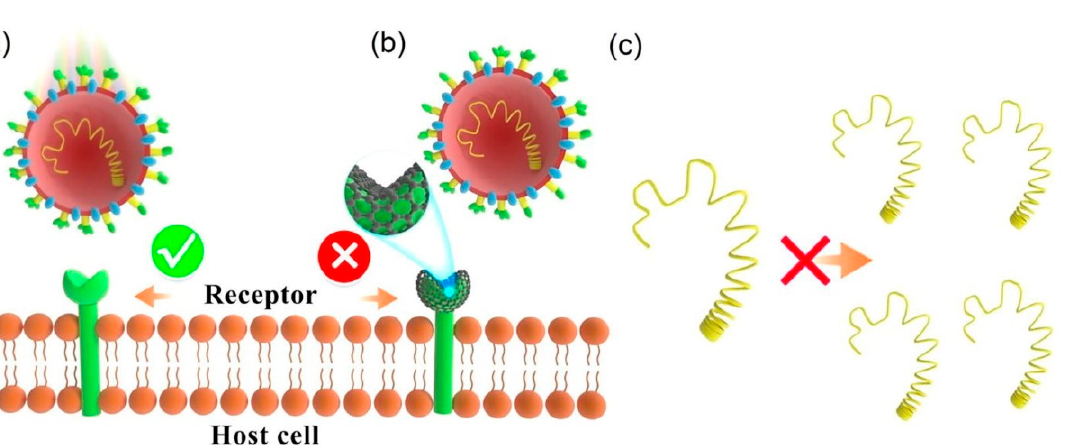
Figure 6. The schematic representation concerning the antiviral activity of functionalized graphene QDs. ( a ) The binding interaction between the S protein of the virus (HCoV-229E) and the host cell receptor causes viral diseases. ( b ) Such binding can be inhibited by the presence of ODs. ( c ) This mechanism can lead to the inhibition of viral genome replication. (Reproduced with permission from Ref. [64]).